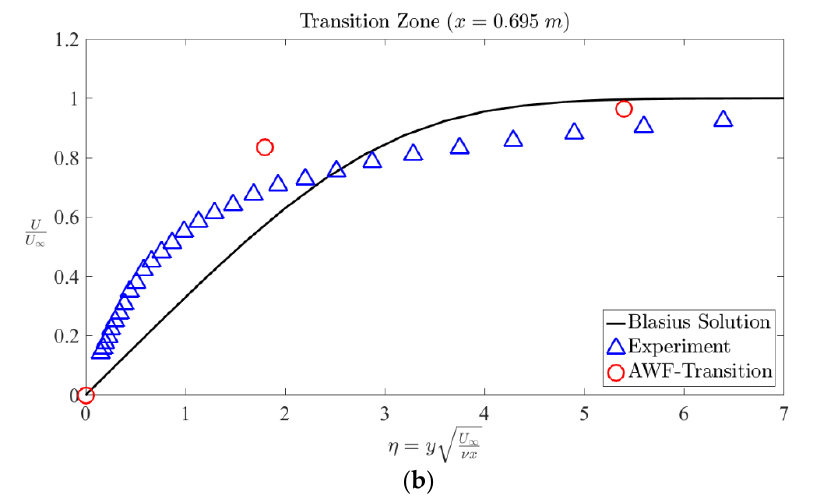
Figure 5. Mean velocity profile of T3A in the transition zone: ( a ) plotted in wall units and ( b ) plotted in the same dimensionless form as Blasius solution.